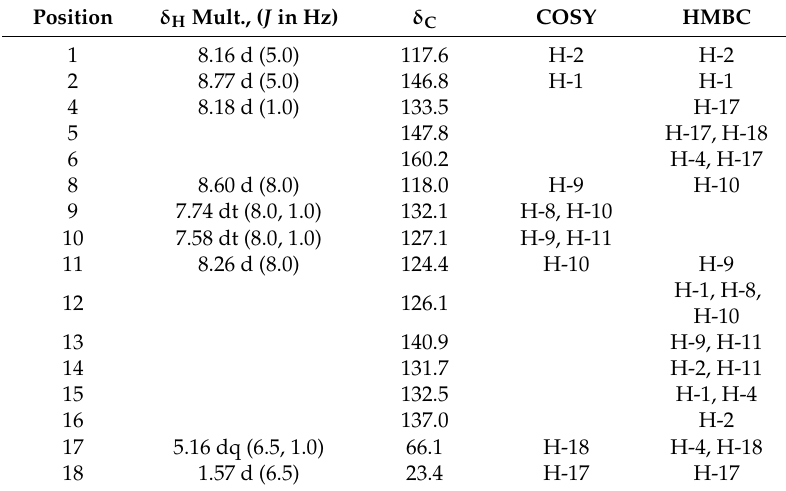
Table 1. 1 H-NMR (500 MHz), 13 C-NMR (125 MHz), COSY, HMBC spectroscopic data for compound 1